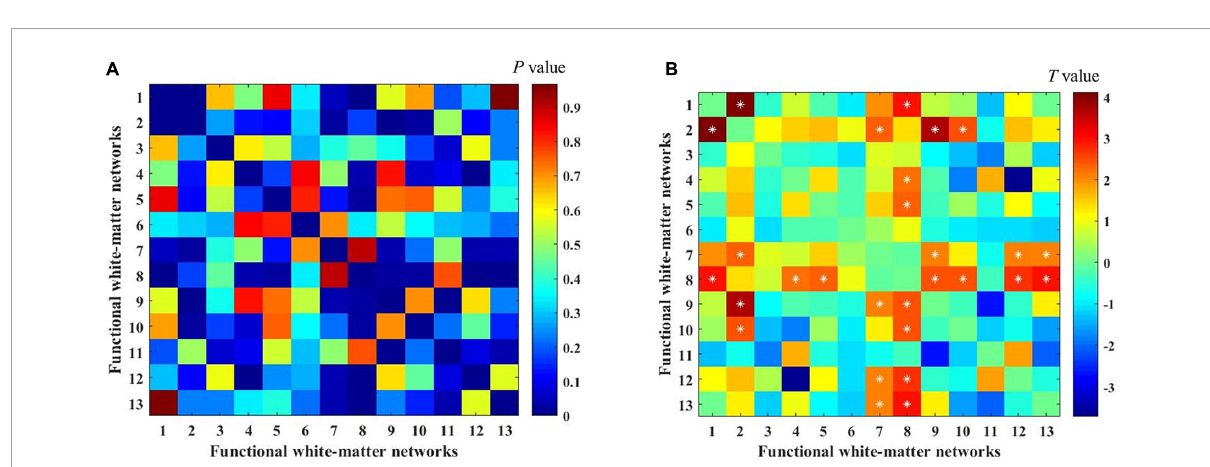
FIGURE4 Differences in functional connectivity between myotonic dystrophy type 1 (DM1) and healthy controls (HCs). (A,B) The color bar showed the P -value and the T -value separately [two-sample t -tests with 1000 permutations, p < 0.05, network-based statistic (NBS) corrected]. *represents significant differences after NBS